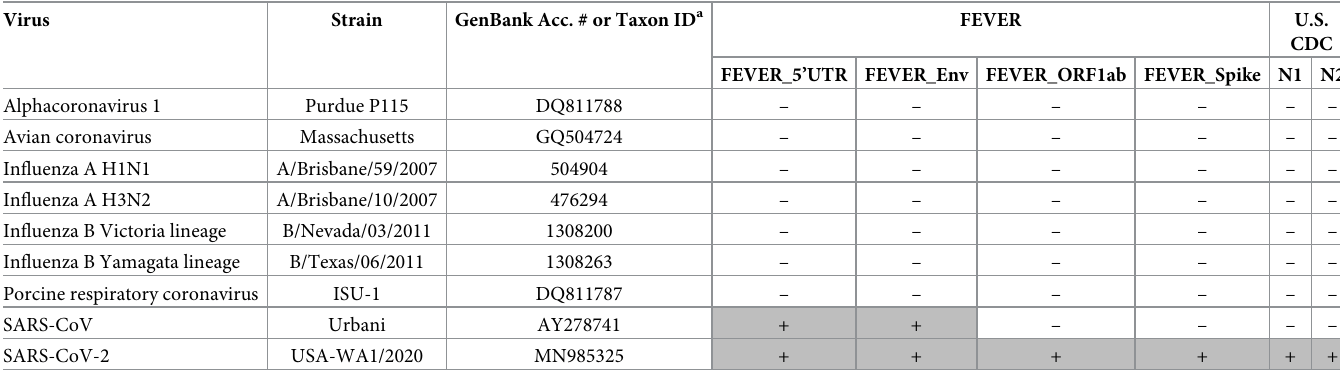
Table 3. Analytical specificity of the FEVER and U.S. CDC